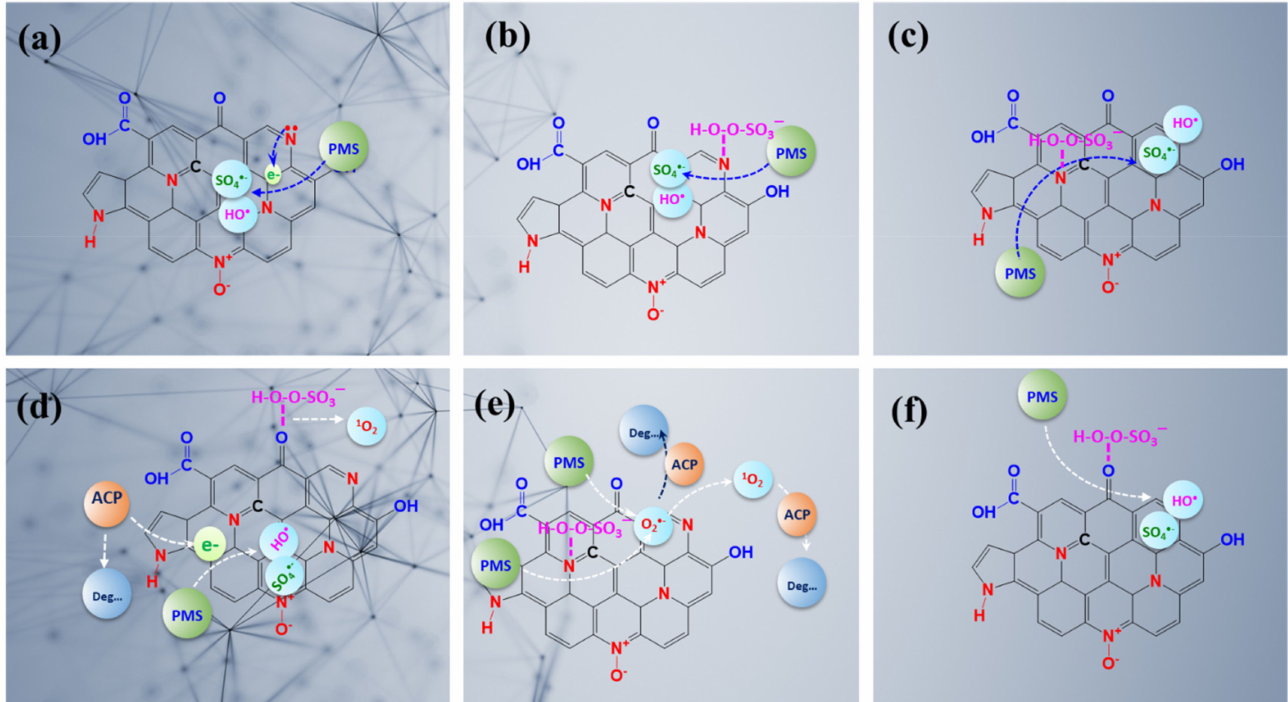
Figure 11. Proposed mechanism in PMS activation by NCNTs, non-radical pathway ( a – d ) and radical pathway ( e – f